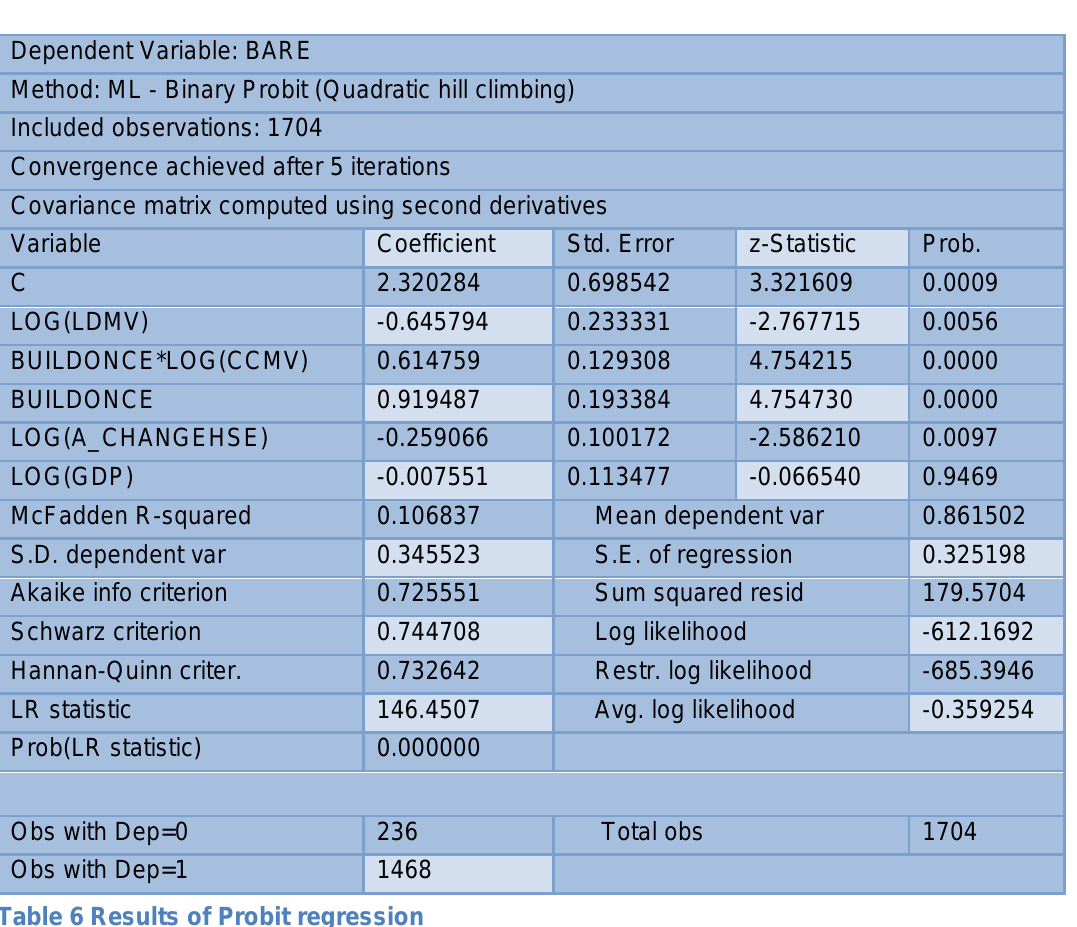
Table 6 Results of Probit